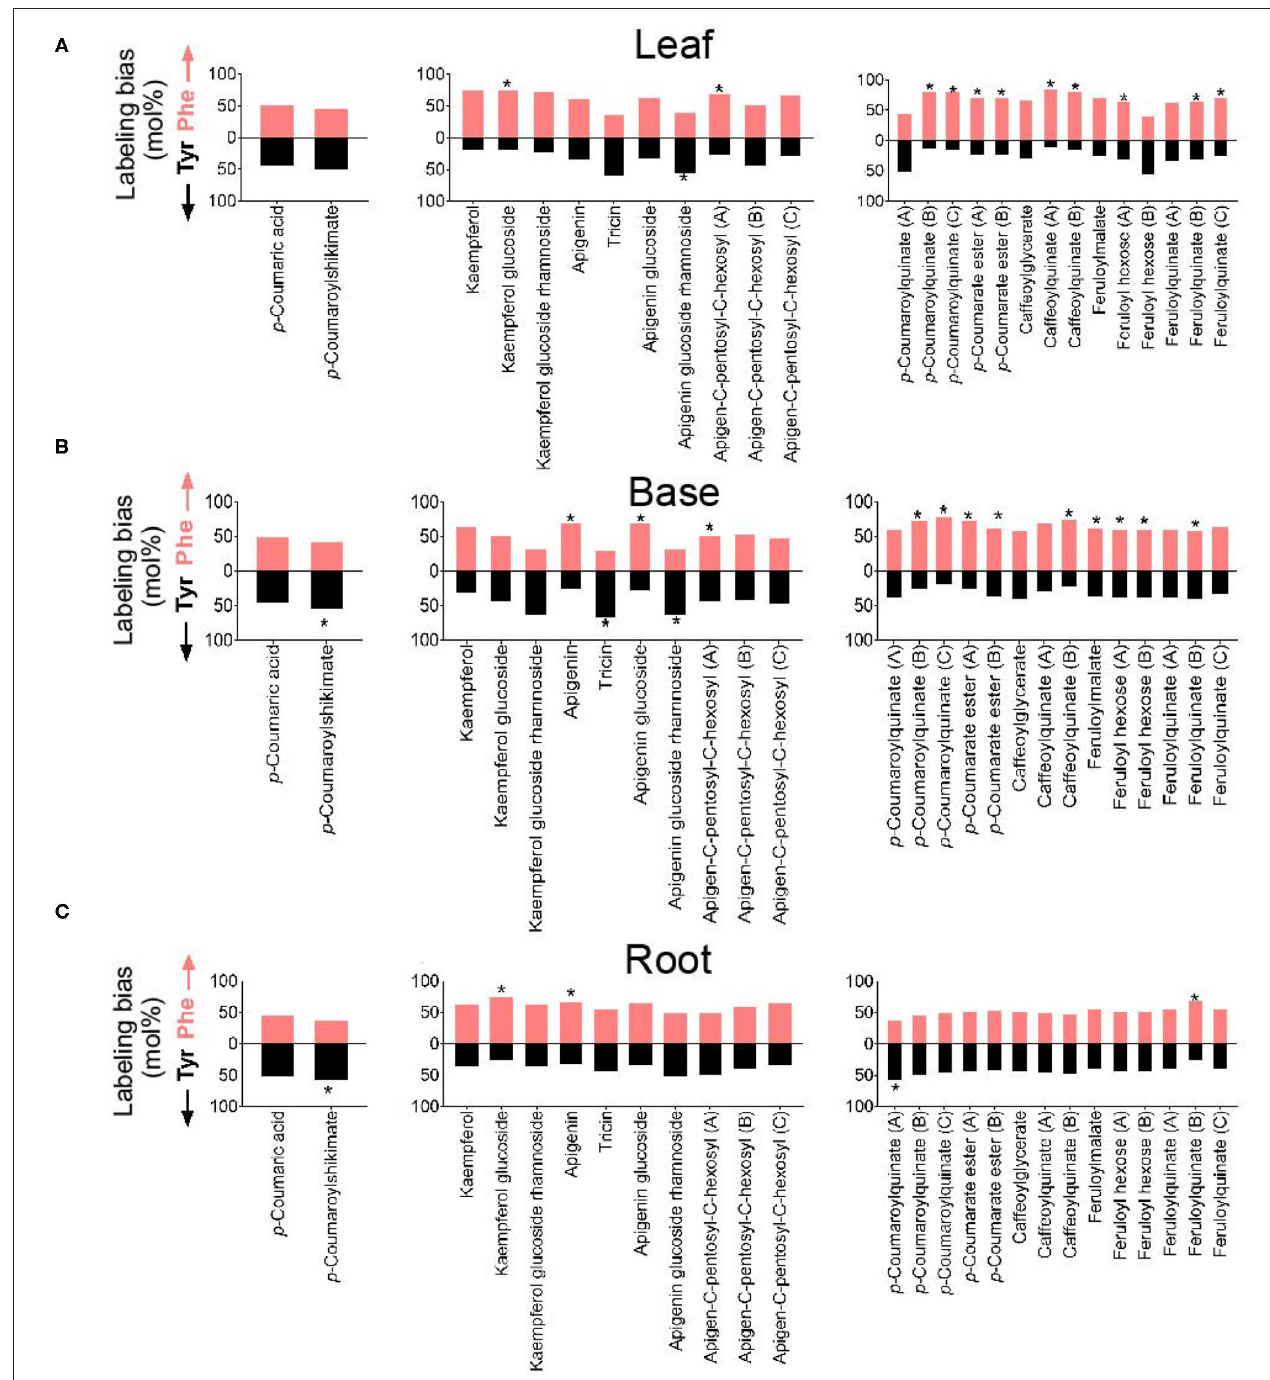
FIGURE 7 | Labeling from 13 C-Phe or 13 C-Tyr (expressed as a mol%) into selected phenylpropanoids in (A) leaf, (B) base, and (C) root segments. The identities of metabolites were corroborated by MS/MS ( Supplementary Table 1 ). Monolignol alcohols and other soluble lignin precursors were not detected in these tissues. The metabolite named “coumaroyl ester” has an m/z of 355.06 and contains a Phe-derived p -coumarate (m/z 163) portion with an unknown non-Phe derived portion of m/z 209.03. Positional isomers are distinguished by the letter following the name of the metabolite and are ordered in the graph from most polar to least polar. Labeling from Phe is denoted by the upper red bar, whereas labeling from Tyr is denoted by the lower black bars. The stars on bars report whether 13 C incorporation into the metabolite was significantly different between Phe and Tyr feedings ( n = 3; p < 0.05).